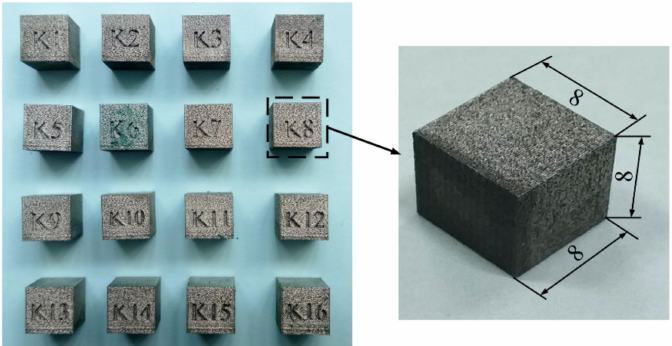
Figure 2. Macro photo of K418 sample manufactured by